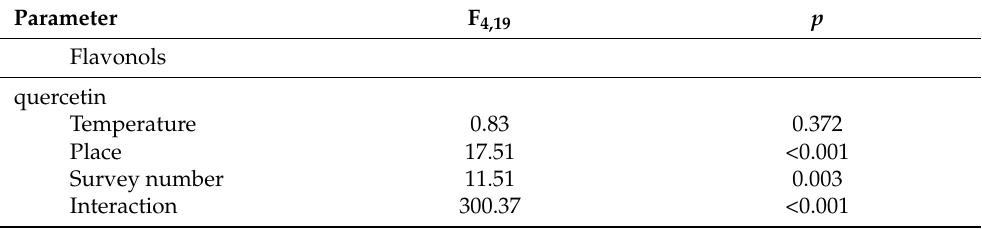
Figure 4. The concentration of individual flavonoids in V. opulus variety Roseum ( A ) and wild plants ( B ) (means ± SE; n = 12). Different letters denote significant differences (one–way ANOVA; Tukey’s test; p < 0.05). Table 5. The effects of temperature, place, survey number and interaction between studied parameters on level of flavonols in V. opulus (GLM, normal error